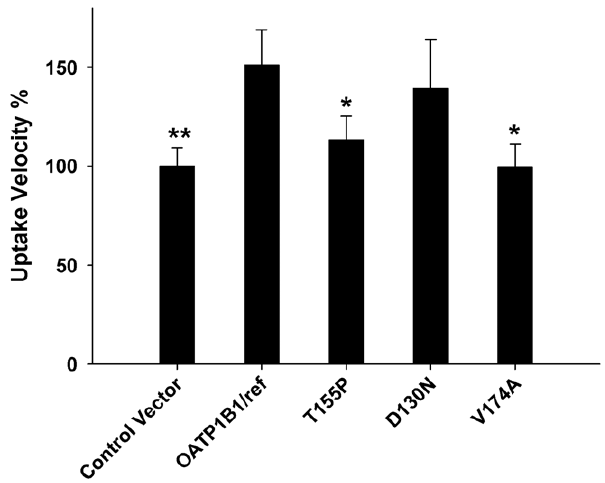
Figure 4. Uptake of flavopiridol in nonsynonymous polymor- phic variants of OATP1B1. The bar graph indicates means + SD for triplicate determinations of 10 m M flavopiridol uptake rates in MDCK-II cells transfected with empty control vector or vector cloned with the reference or polymorphic SLCO1B1 genes. All incubations were for 10 min. Variants are indicated with respect to their amino acid change; T155P=rs11045819, D130N=rs2306283, V174A=rs4149056. Transport rates were normalized to empty vector control. Differences in uptake rates were compared to the reference OATP1B1 transporter. * p , .05, ** p , 0.01, Student’s t-test.